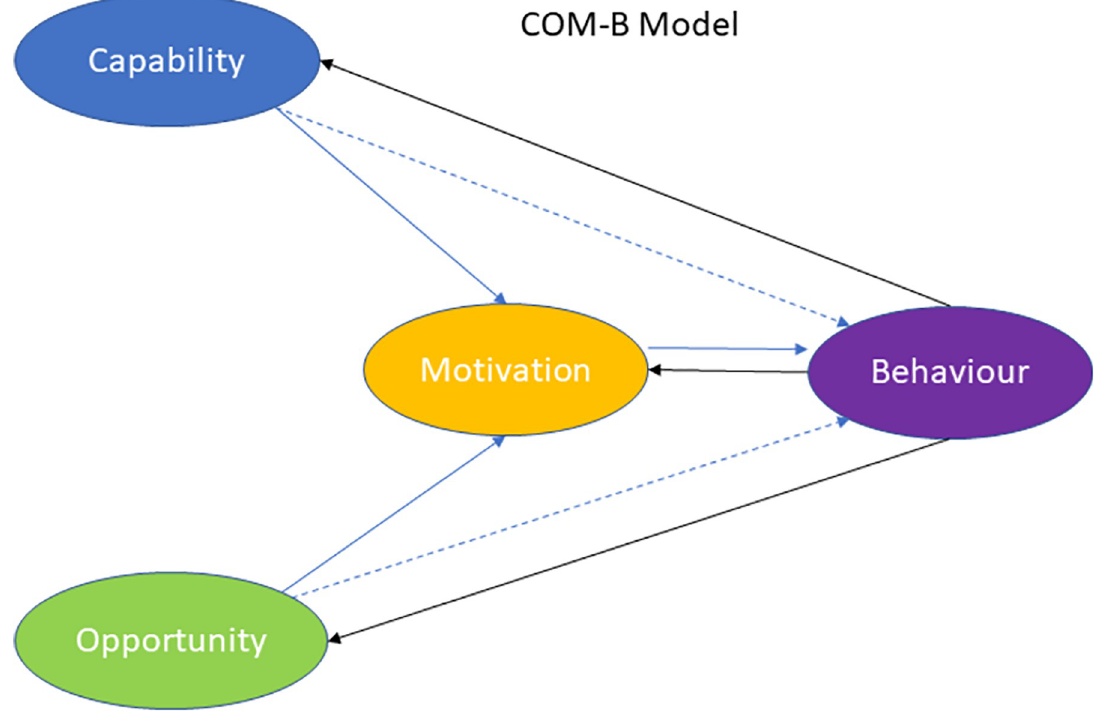
Fig 1. COM-B model. Adapted from West & Michie